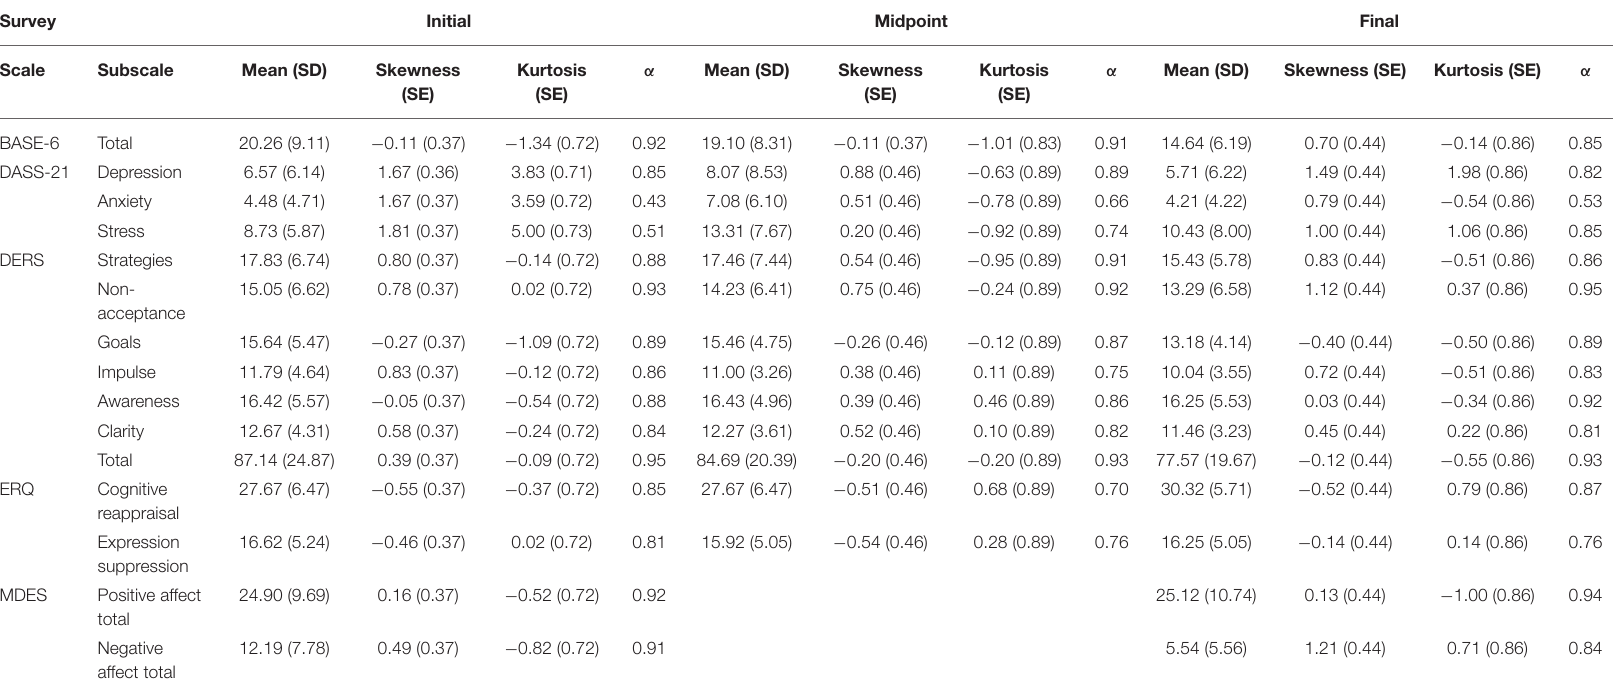
TABLE 4 | Pilot study descriptive statistics and scale reliabilities for the full sample prior to data analysis or manipulation.